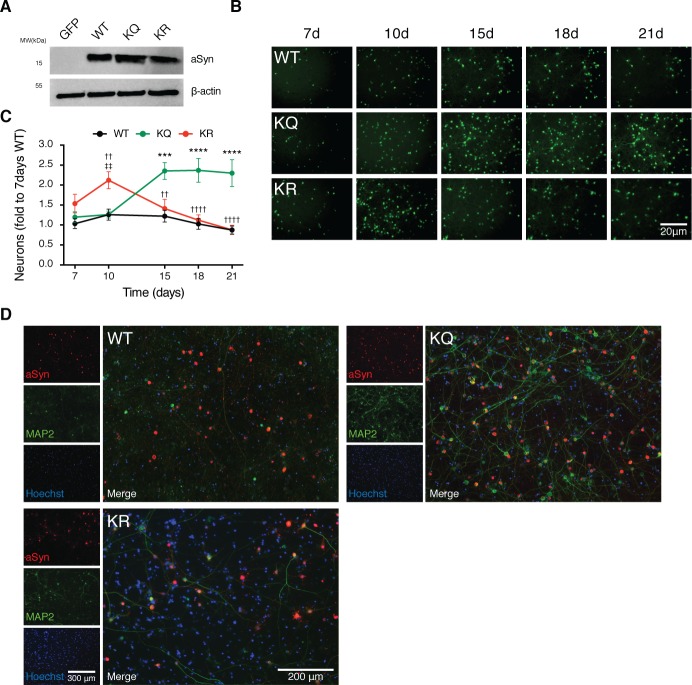
aSyn acetylation mimic is neuroprotective in primary cortical neurons.(A) Cultured primary neurons were transduced with AAVs encoding for EGFP, WT aSyn, KQ, or KR-mutant aSyn at day in vitro 3 (DIV3). Whole-cell lysates were analyzed by immunoblotting 7 d postinfection with antibodies against aSyn and β-actin (n = 3). (B) Primary neuronal cells were coinfected with aSyn and EGFP at DIV3 and monitored over time. 16 images per condition were acquired, and the EGFP fluorescence signal was recorded in living neurons at 7, 10, 15, 18, and 21 d posttransduction (n = 3). Representative images are shown. Scale bar 20 μm. (C) Total number of EGFP positive cells normalized to the number of neurons on WT 7 d posttransduction is presented (n = 6). Data in all panels are average ± SD, * p < 0.05, ** p < 0.01, *** p < 0.001, two-way ANOVA with Bonferroni post-test. (D) Cortical neuronal cells 15 d posttransduction were processed for ICC (aSyn, red; microtubule-associated protein 2 [MAP2], green; nuclei, Hoechst, blue). Representative images are presented. Scale bar 200 μm. Data in S1 Data.